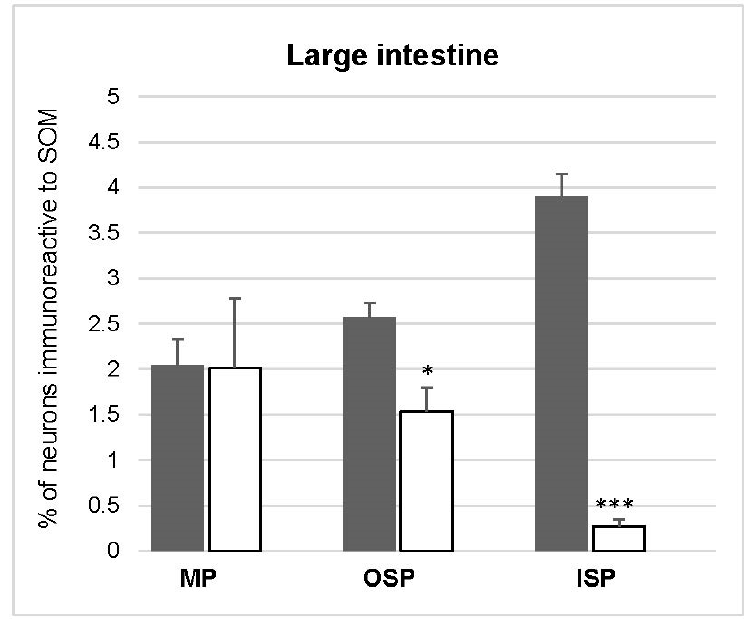
Figure 6. Mean ( ± SEM) of SOM, like immunoreactive (SOM-IL), neurons in the myenteric plexus, outer submucosal plexus, and inner submucosal plexus of large intestine in the control (white bars) and streptozotocine-induced diabetes groups (grey bars). Data are presented as mean ± SEM and statistically significant data (* p < 0.05, ** p < 0.01, and *** p < 0.001).